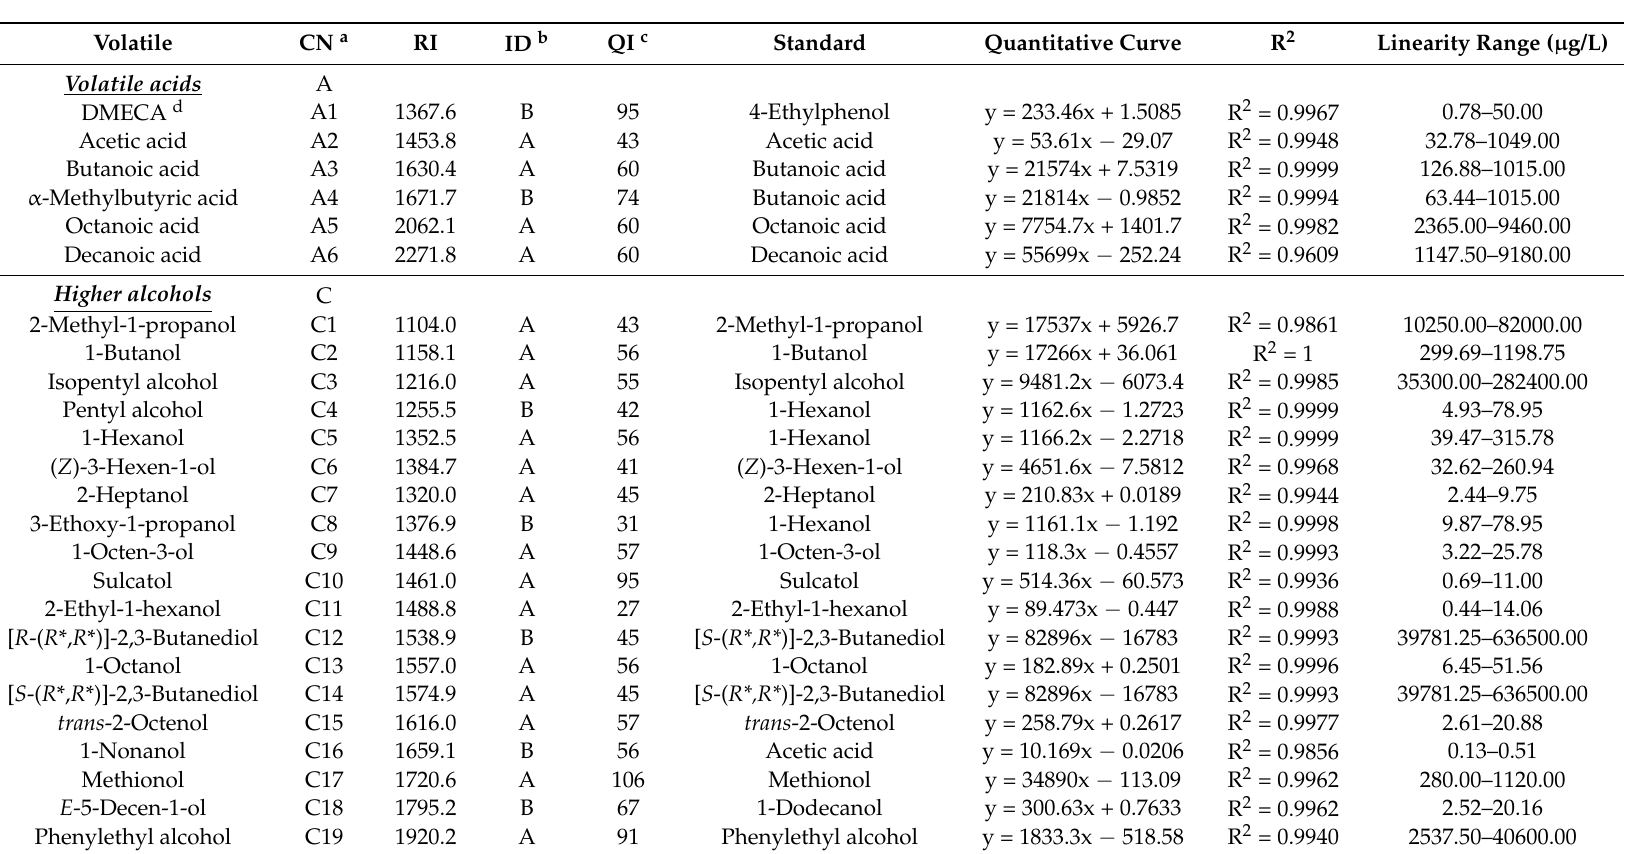
Table 2. Volatile compounds identification and their linearity